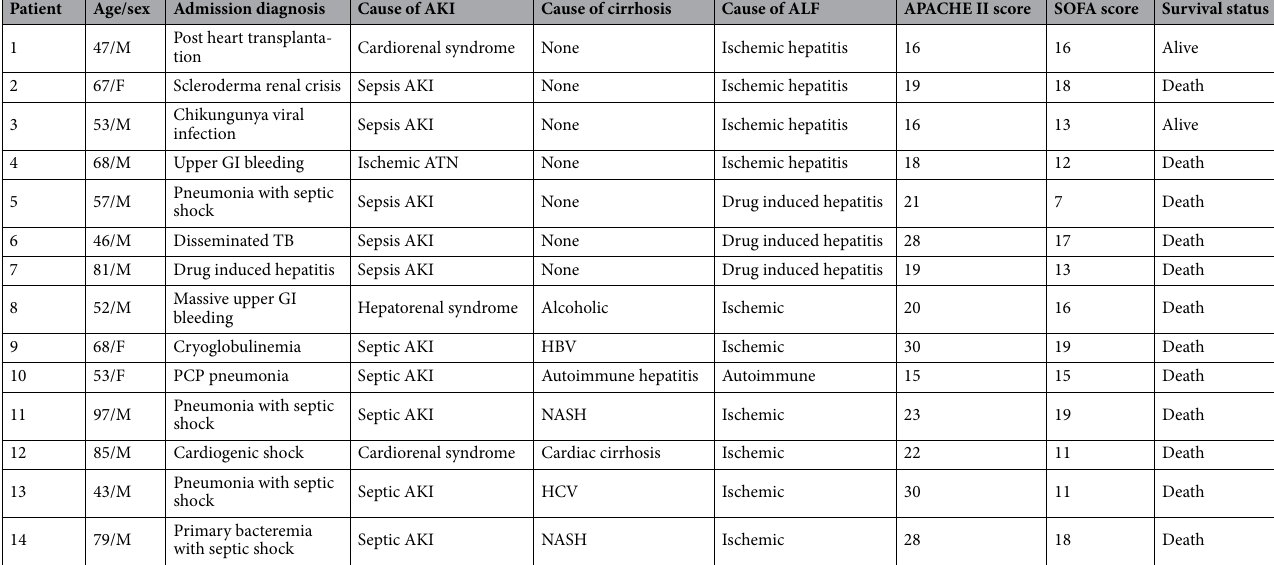
Table 1. Baseline characteristics. AKI acute kidney injury, APACHE II score Acute Physiology and Chronic Health Evaluation II score, GI gastrointestinal, HBV hepatitis B virus, HCV hepatitis C virus, NASH